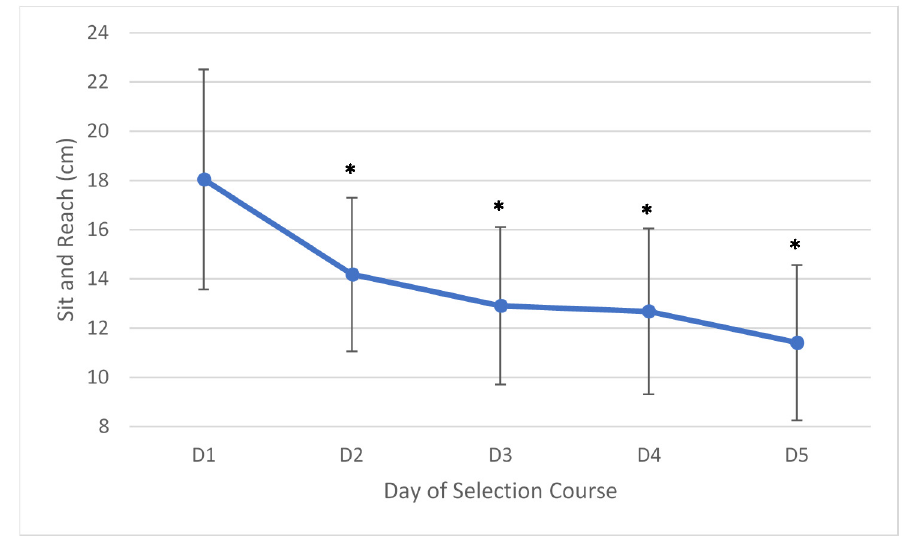
Figure 3. Average changes (±SD) in sit-and-reach flexibility over the five days. * = Significantly less than day one ( p < 0.05).